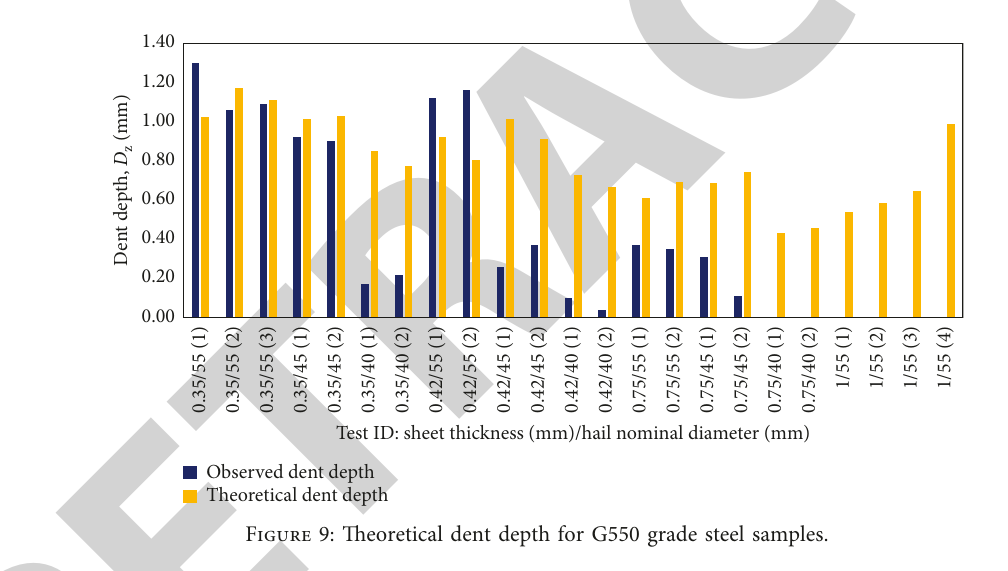
Figure 8: Dent depth and diameter for 0.35mm steel samples having G550 and G300 grades.